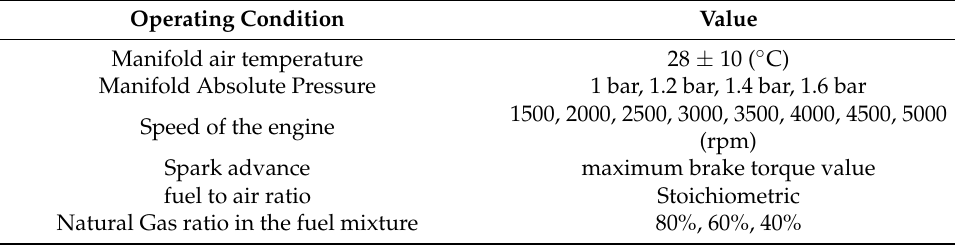
Table 2. Operating conditions